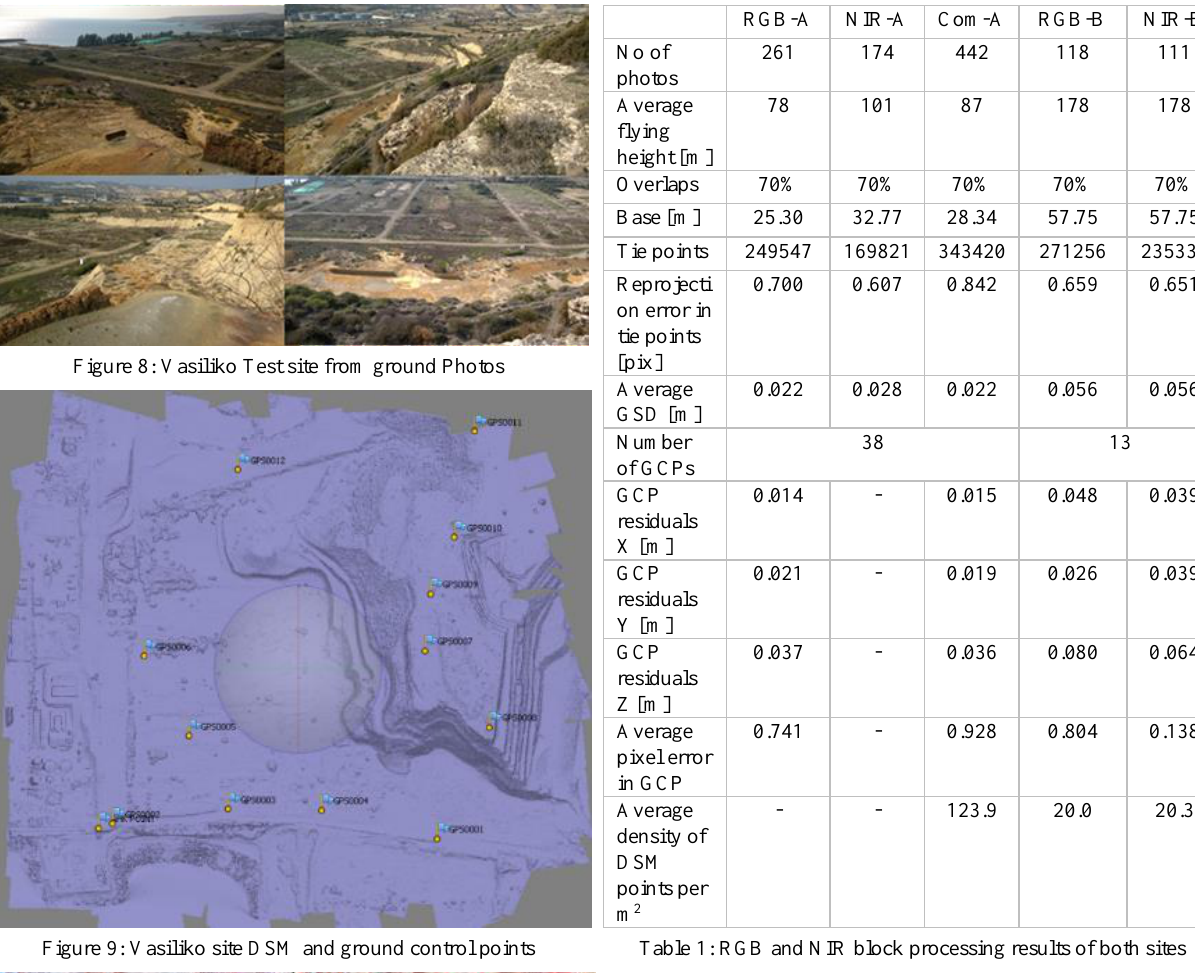
Figure 9: Vasiliko site DSM and ground control points